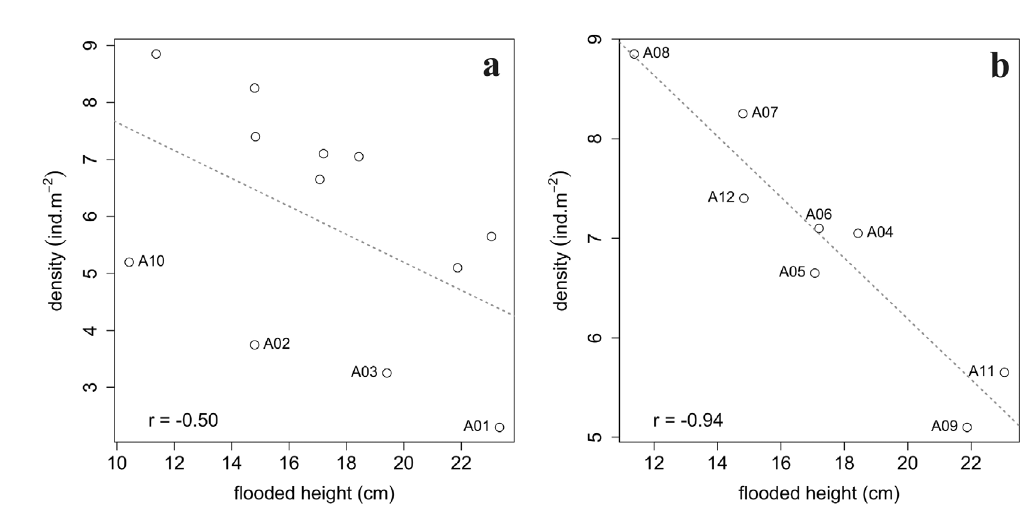
Figure 3 - Relationship between Ucides cordatus density (ind.m -2 ) and flooding height (cm), with identification of four outlier points removed of the analysis ( a ), and the remaining points used to data reanalysis ( b ).